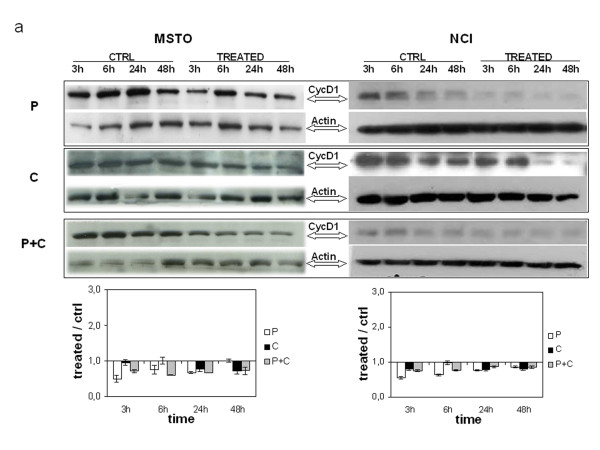
Effects of piroxicam alone and in combination with CDDP on cell cycle regulatory proteins. CycD1 was analysed by western blotting in MSTO (left side) and NCI (right side) treated with piroxicam and/or CDDP for different times. Electrophoretic bands were analyzed using Scion Image program. Experiments were repeated in triplicate and media values and standard deviations were calculated. CTRL = control; P = piroxicam; C = CDDP.